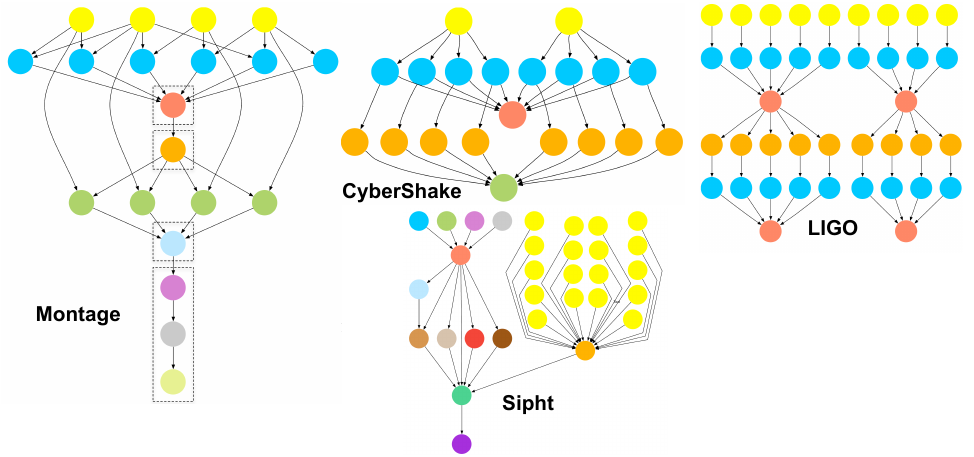
Figure 4. The structures of the Montage, CyberShake, LIGO, and Sipht